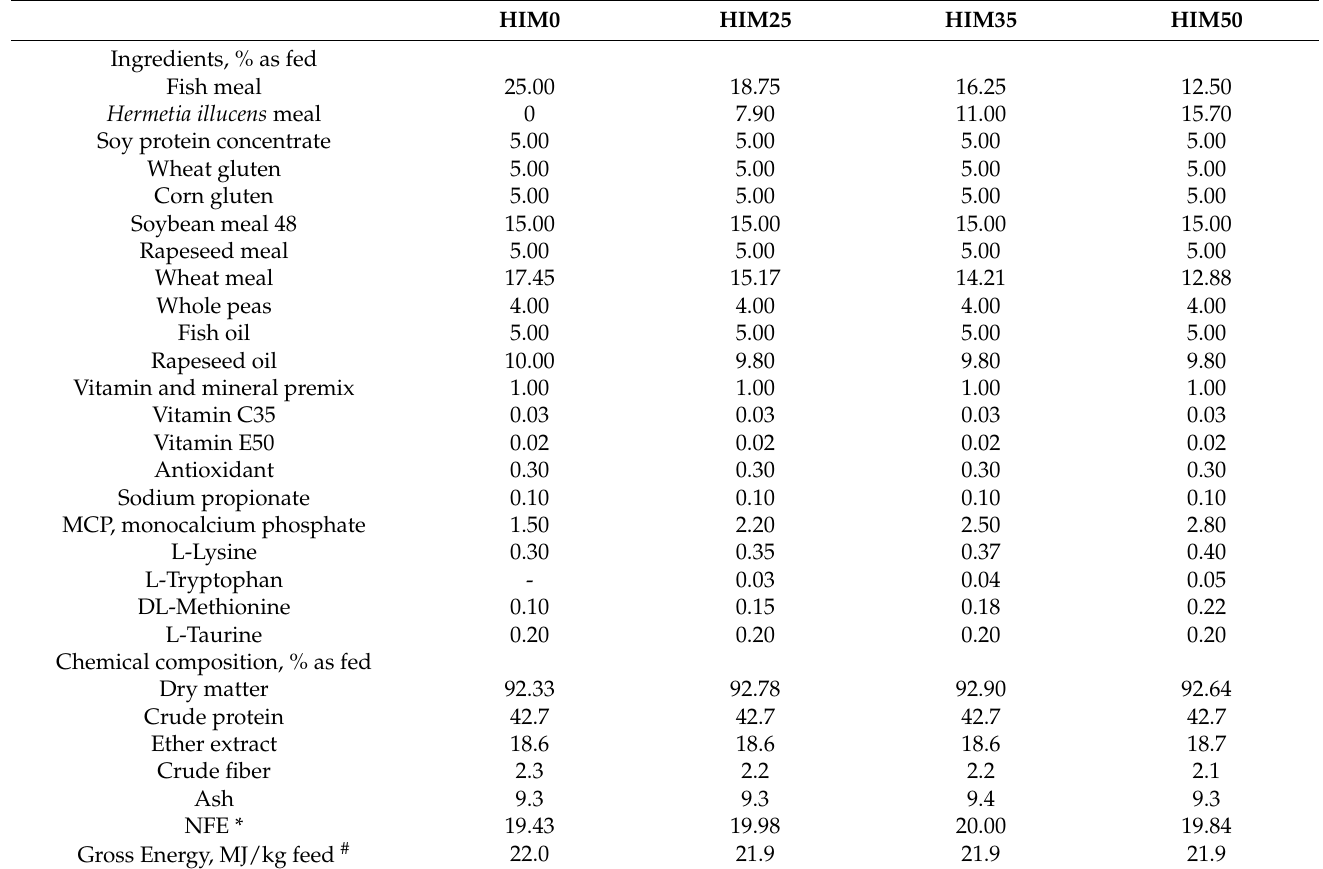
Table 1. Diet ingredients and proximate composition of the experimental